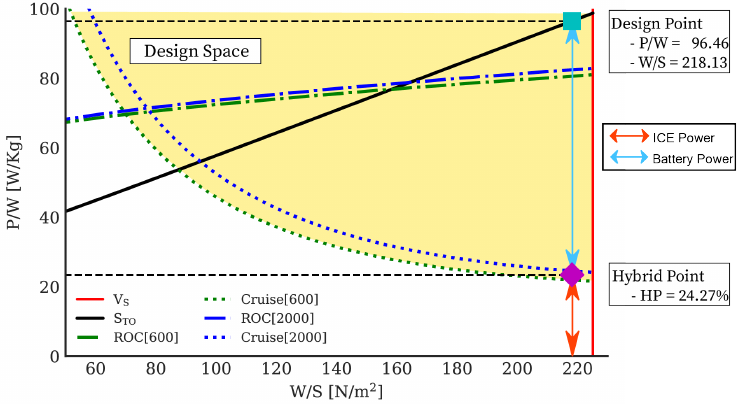
Figure 8. Constraint Analysis